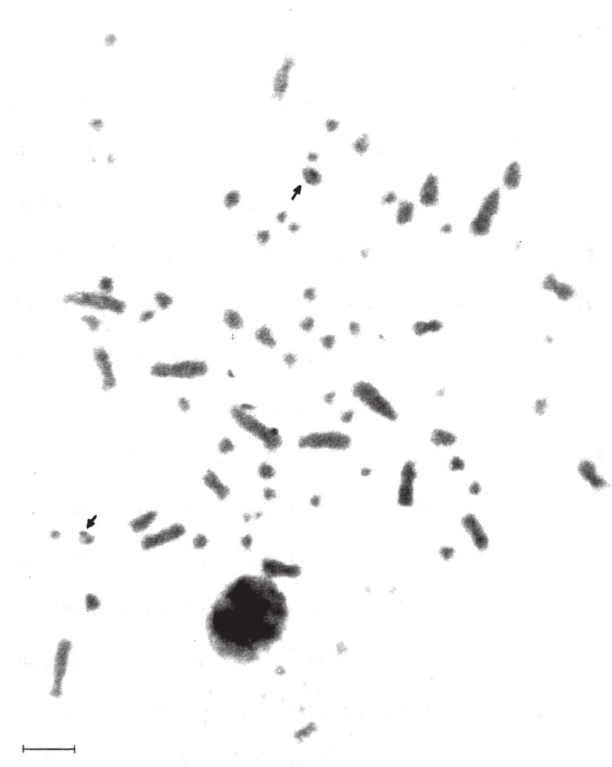
Figure 4. Nucleolus organizer regions in Nyctibius griseus . The arrows indicate NORs positioned in a strong secondary constriction probably of one pair of small one armed autosomes. Bar = 5